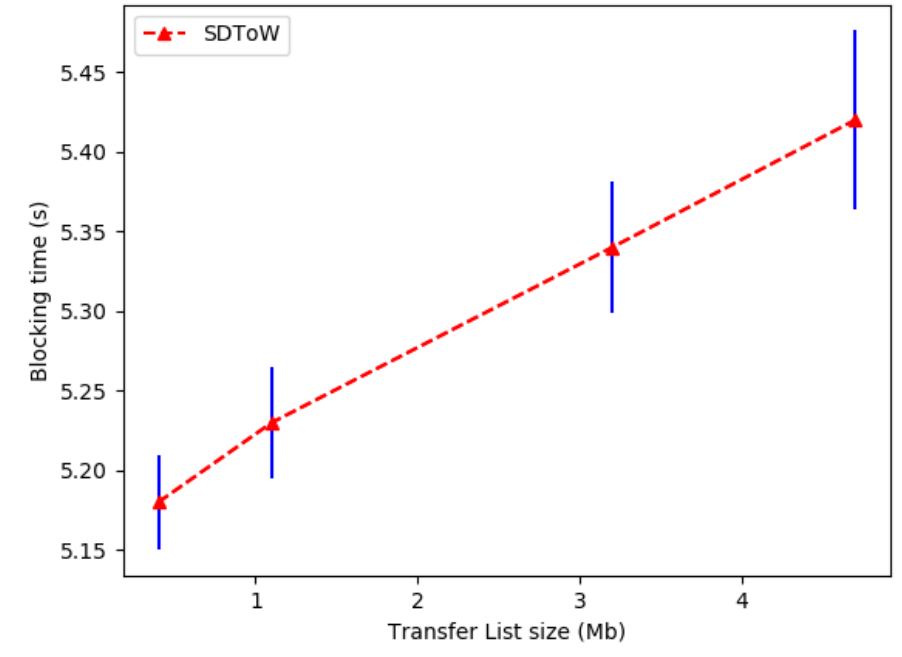
Figure 8. The influence of the traffic list size on the total blocking